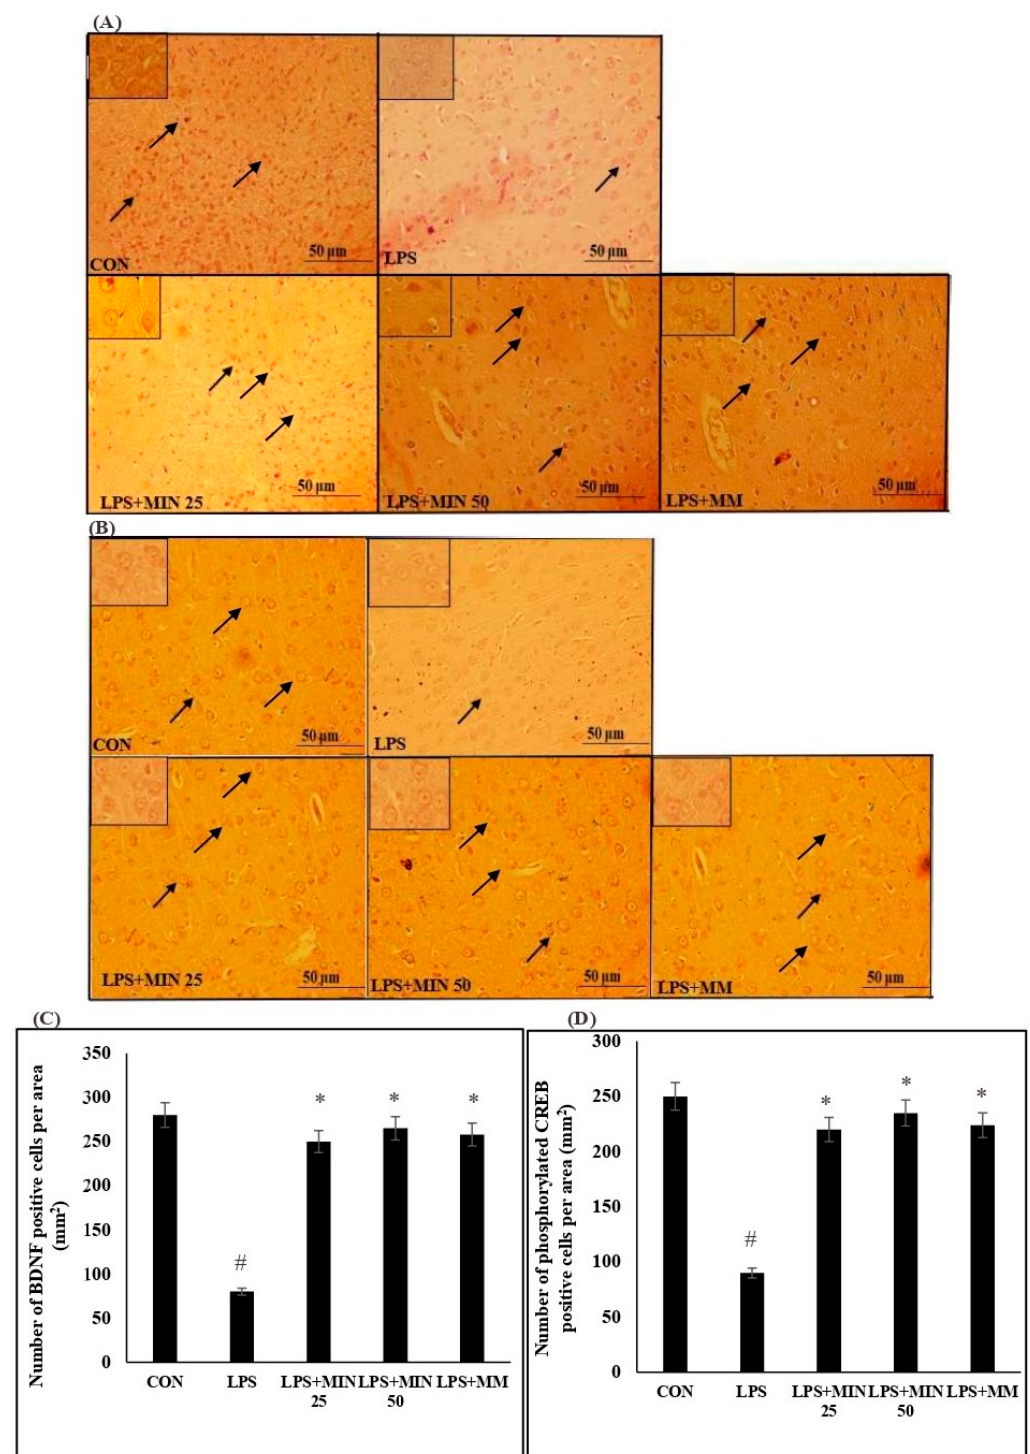
Figure 3. Distribution of BDNF- ( A ) and phosphorylated CREB-positive cells ( B ) in the mPFC at 40× and 100× magnification. The black arrows indicate BDNF- and phosphorylated CREB-positive cells. ( C ) Total number of BDNF- ( D ) phosphorylated CREB-positive cells in the mPFC.